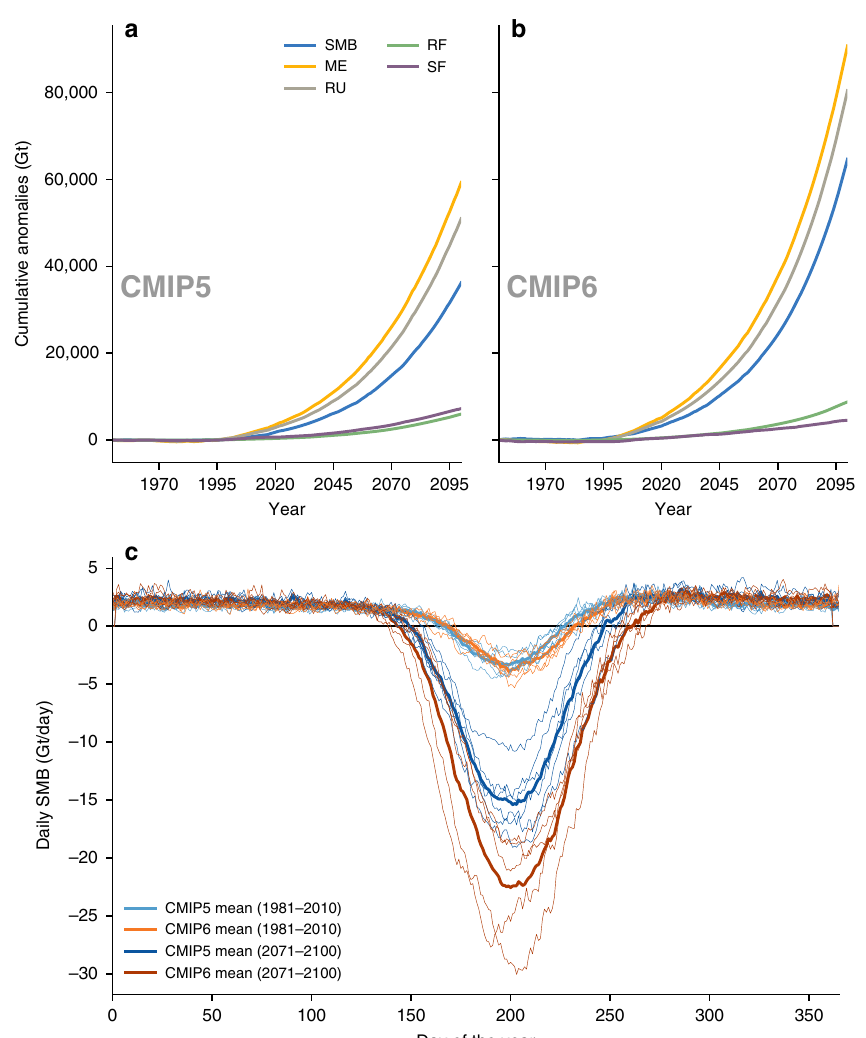
Fig. 6 Greenland Ice Sheet surface mass balance components and annual surface mass balance cycle in CMIP5 and CMIP6. a Cumulative SMB component anomalies from the mean of all six CMIP5 (RCP8.5) MAR simulations based on the 1961 – 1990 mean of the simulations. “ ME ” corresponds to the cumulative melt-, “ RU ” to the runoff-, “ RF ” to the rainfall-, and “ SF ” to the cumulative snowfall anomalies — all in Gigatonnes (Gt). Note: the negative SMB anomalies are multiplied by -1 for better visible comparison with positive melt anomalies. b Same as a but based on the mean of all fi ve CMIP6 SSP585 MAR simulations. c Annual SMB cycle (Gt/day) from CMIP5 RCP8.5 (blue) and CMIP6 SSP585 (orange) forced MAR simulations for two different 30-year periods (1981 – 2010 and 2071 – 2100). The thicker lines represent the CMIP5 and CMIP6 MAR simulation mean, whereas the individual simulations are shown in thinner